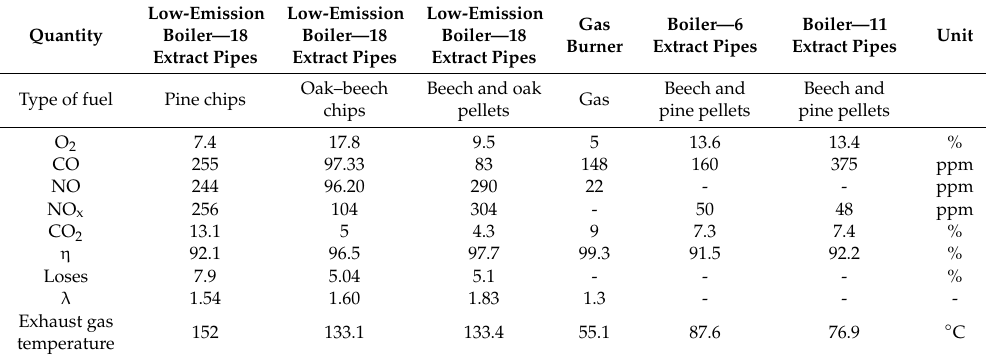
Table 6. Comparison of the exhaust gas analysis results from the test object with the literature data.